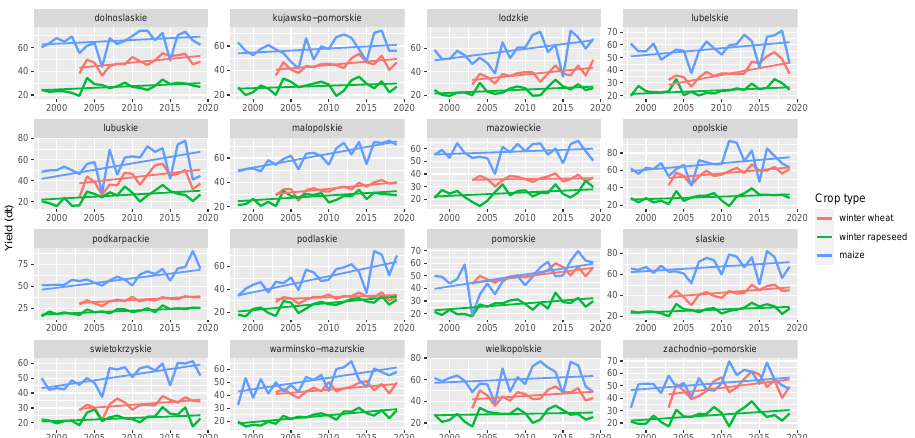
Figure 5. Absolute annual crop yields for NUTS-2 units reported by Statistics Poland with a fitted Theil–Sen monotonic trend. Please mind different limits of Y-axes.